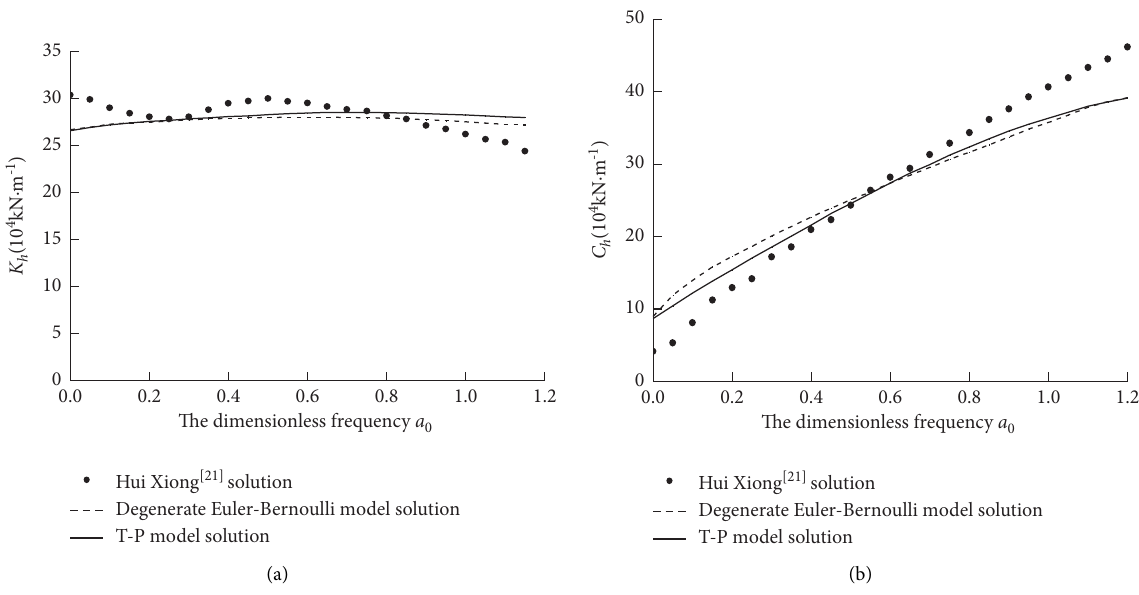
Figure 4: Variation in pile top impedance with frequency in layered soil. (a) Horizontal dynamic stiffness. (b) Horizontal dynamic